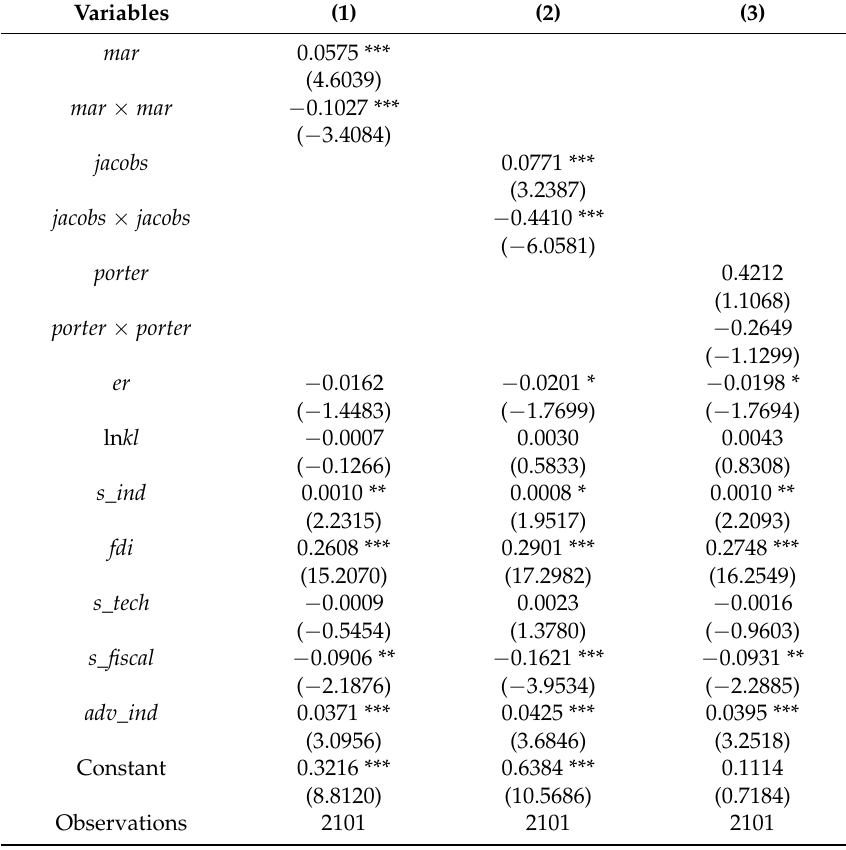
Table 10. Robustness check: alternative approach by Simar and Wilson